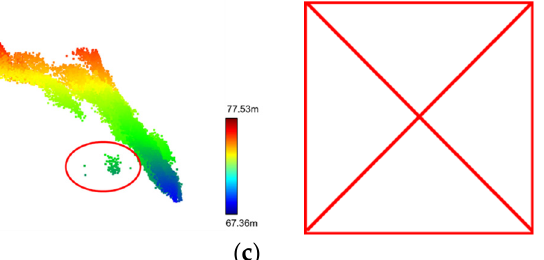
Figure 22. Illustrations of clearly visible cisterns in the UAV LiDAR point cloud and corresponding imagery which are ( a ) easy to see in the images, ( b ) hard to see in the images, and ( c ) no image available.